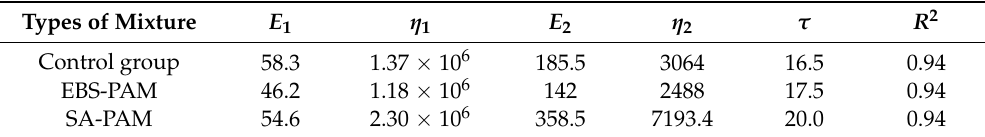
Table 10. The fitting